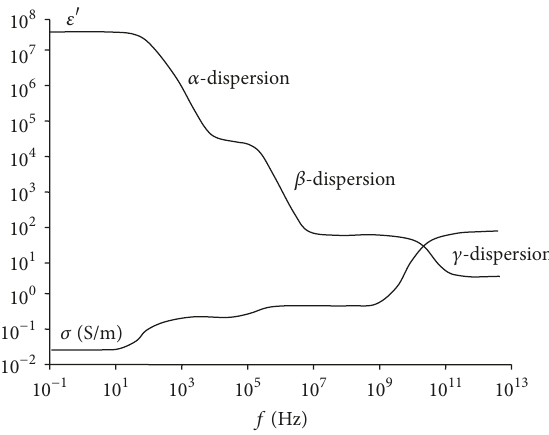
Figure 2: Three dispersions in biological system [ 𝜎 ( S / m ) repre- sentselectricconductivityand 𝜀 󸀠 representsdielectricconstant][23].